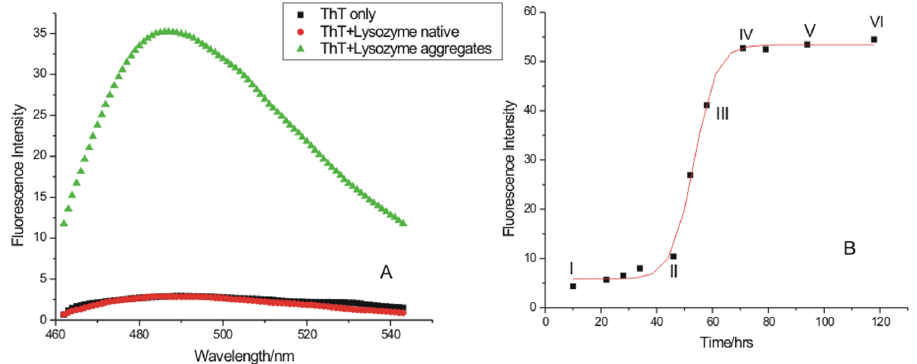
N Figure 1. Fluorescence emission intensity accompanying the binding of ThT with amyloid fibrils after 72 h of incubation in the ) ThT + native lysozyme, ( m ) ThT + lysozyme aggregates (Panel A); and kinetics of the lysozyme amyloid presence of ( & ) ThT, ( formation (Panel B), point I shows lysozyme at the native state, point II denotes the end of nucleation period and beginning of the elongation stage, point III shows lysozyme at the middle of the elongation period and points IV, V and VI denotes the saturation stages of lysozyme. doi:10.1371/journal.pone.0104600.g001 PLOS ONE |